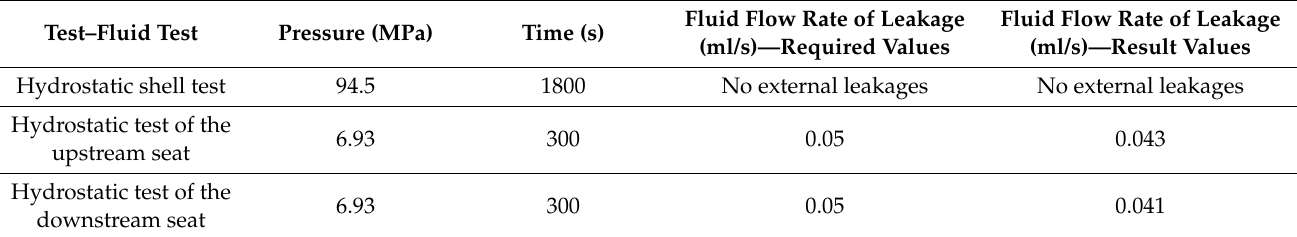
Table 2. Results of hydrostatic tests performed with water as the working fluid.